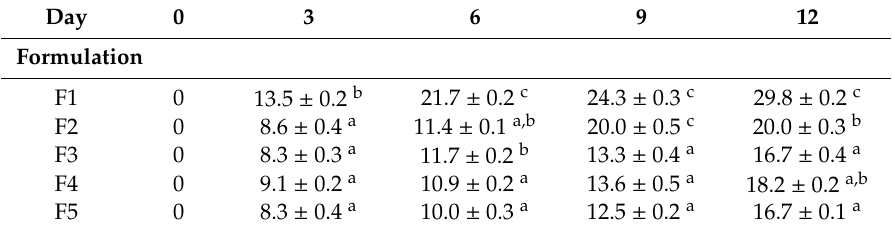
Table 3. Evolution of weight loss percentage evolution in tomatoes with CS + RGEO